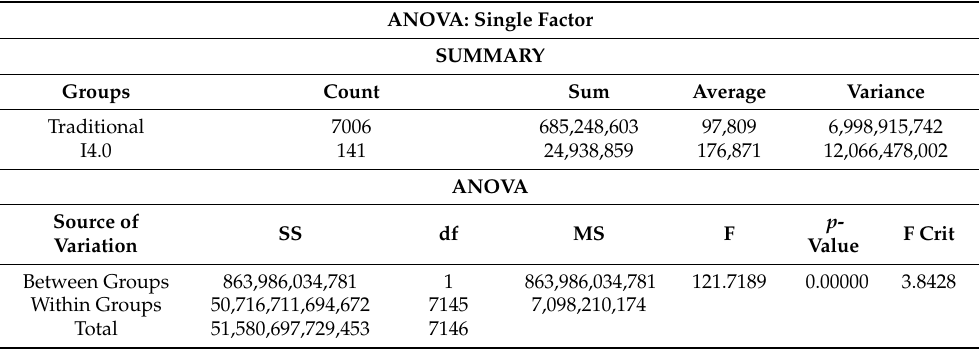
Table 6. ANOVA of average employee cost.